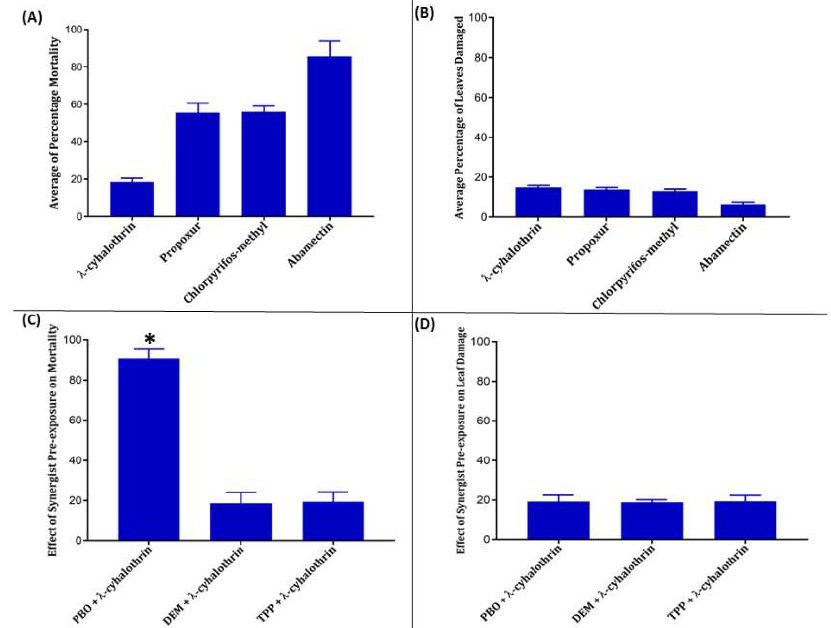
Figure 3. Results of conventional and synergist bioassays with various concentration of insecticides. Average of percentage for six different concentration ranges for each insecticides ± standard error of mean, for ( A ) mortalities, ( B ) leaves damaged, ( C ) mortalities with pre-exposure to synergists PBO, DEF, and DEM, and ( D ) leaves damaged from synergist bioassay with PBO. * Significantly different from conventional test with λ -cyhalothrin only, χ 2 = 98.35, p < 0.0001. Table 1. Susceptibility profiles mortalities) and leaf damage from exposure to various insecticides and